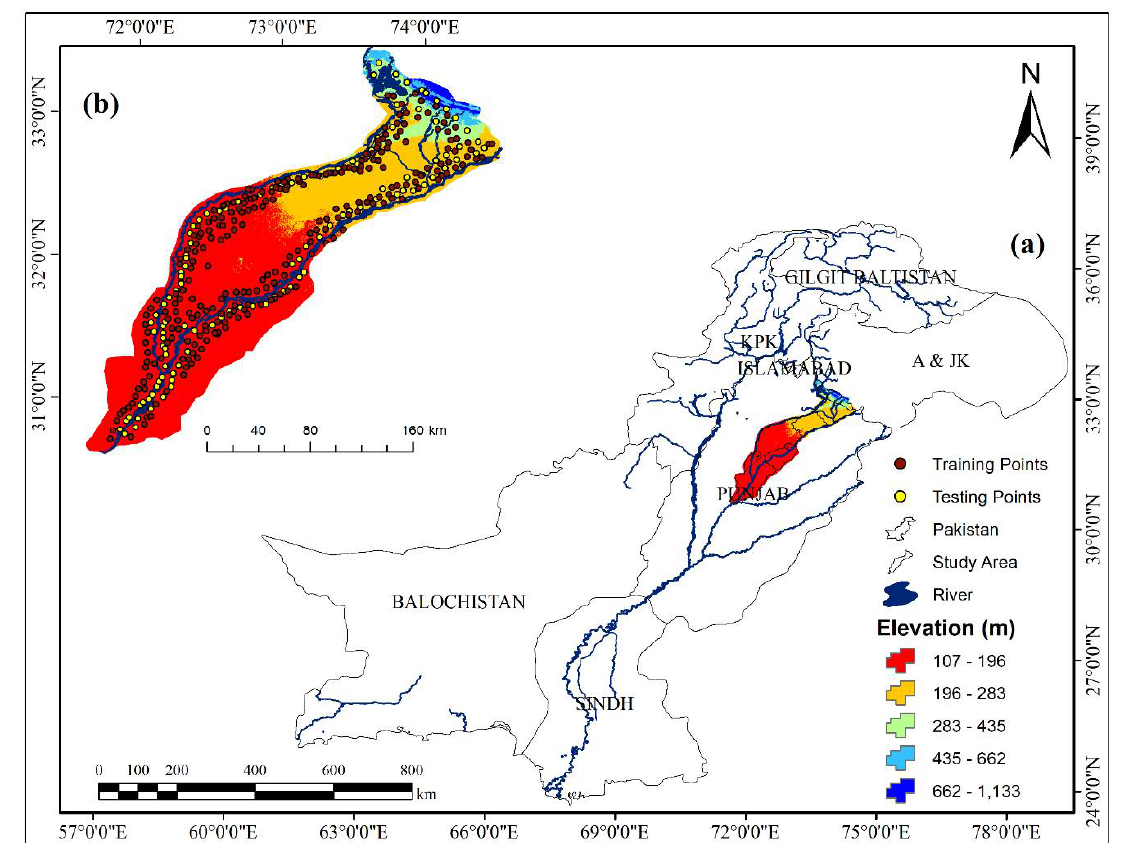
Figure 1. In this study, ( a ) indicate where study area is exists in Pakistan ( b ) Location of study area and the experts employed a variety of training and testing locations, which may be seen on a